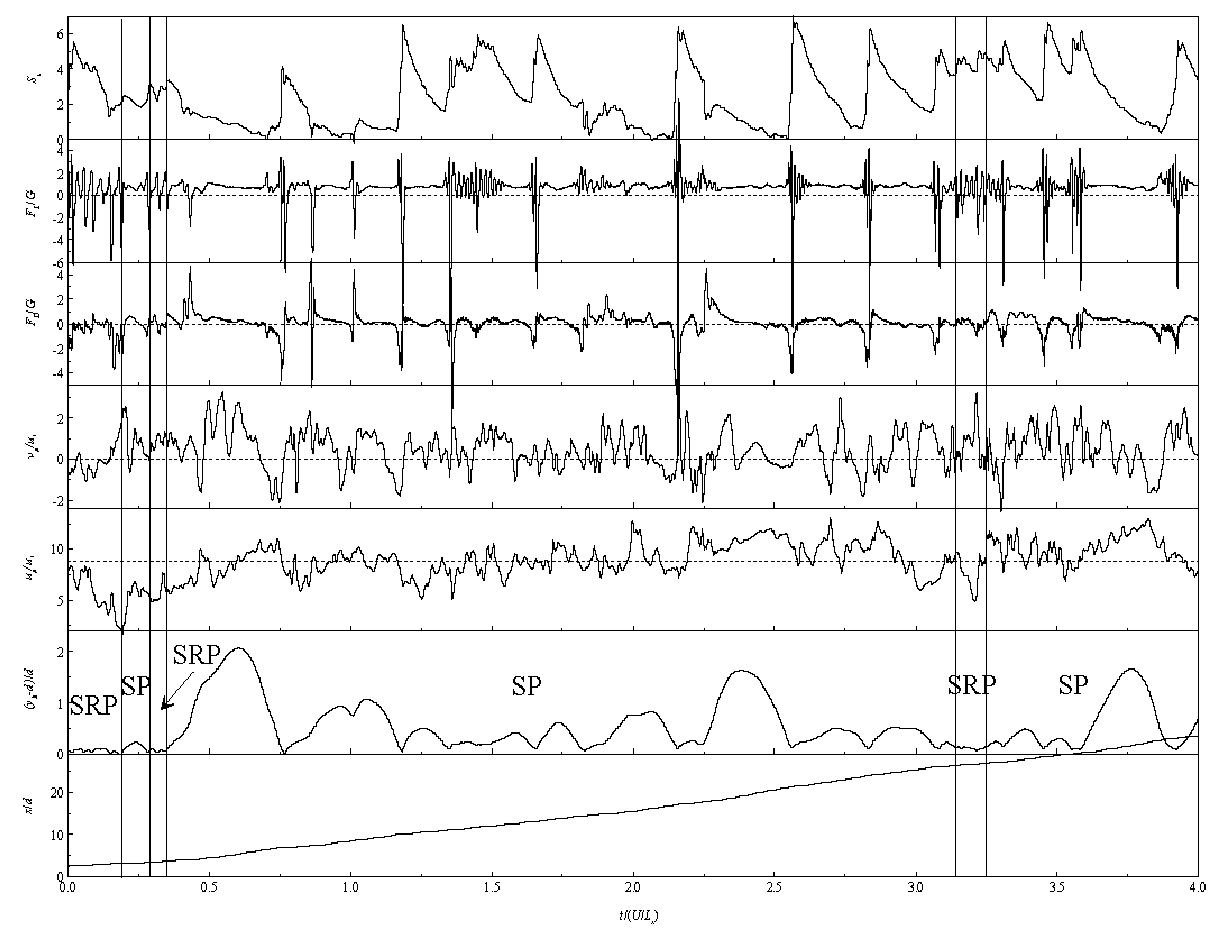
Figure 6. Typical continuous trajectories and dynamic behaviors of individual sediment particle movement (sliding, or rolling and saltation), and the corresponding hydrodynamic forces exerted on the particle. x p and y p = streamwise and vertical center coordinates of the particle, respectively; u p and v p = streamwise and vertical velocities of the particle, respectively; F D and F L = drag and lift forces of hydrodynamic forces exerted on the particle, respectively; s x = angular velocity of the particle; and G = particle submerged weight.